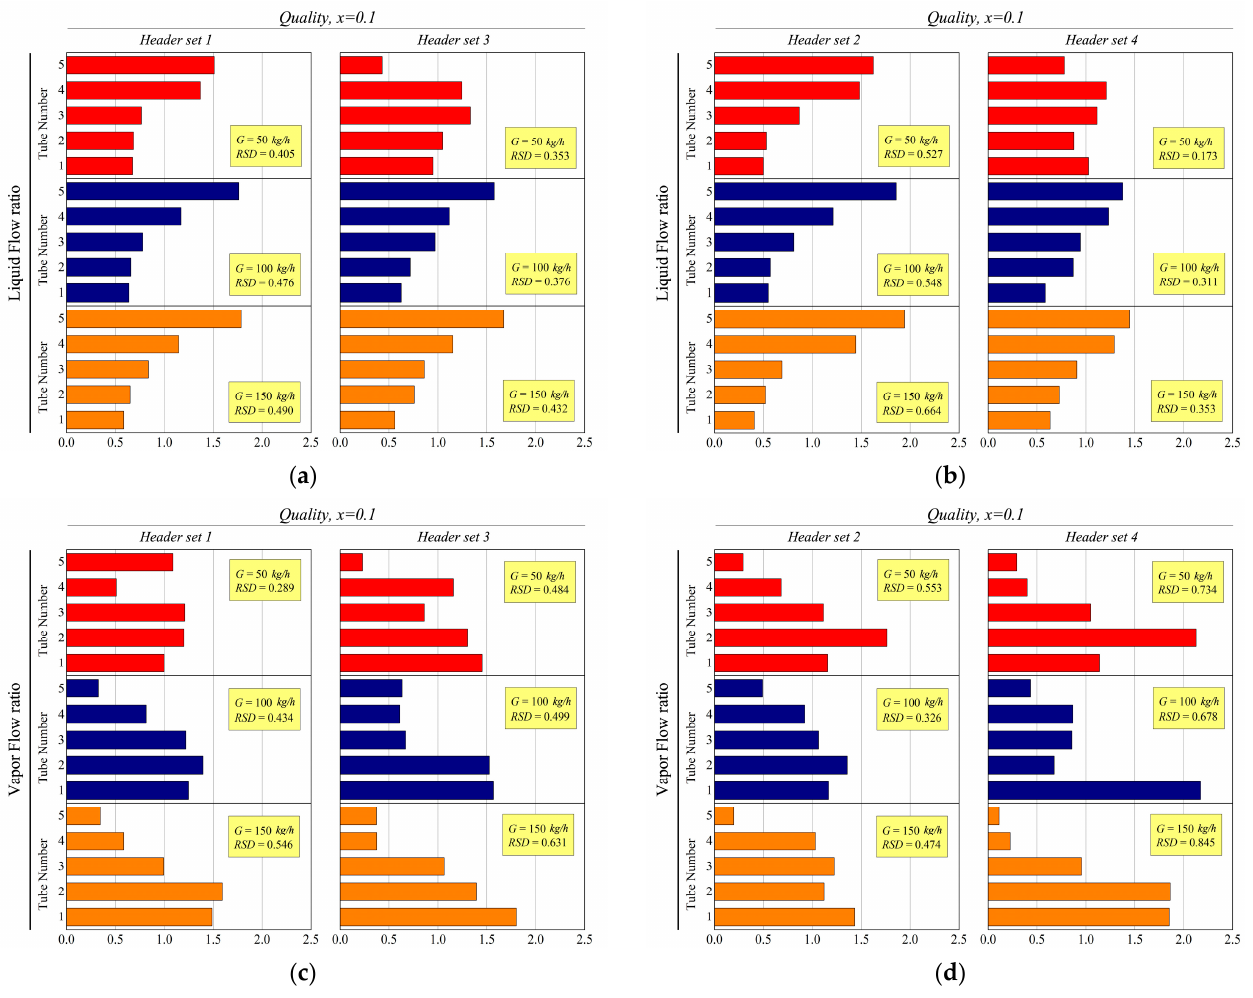
Figure 9. Effect of header height to flow distribution profile: ( a ) liquid flow ratio, header sets 1 and 3 (190 mm and 490 mm); ( b ) liquid flow ratio, header sets 2 and 4 (190 mm and 490 mm); ( c ) vapor flow ratio, header sets 1 and 3 (190 mm and 490 mm); ( d ) vapor flow ratio, header sets 2 and 4 (190 mm and 490